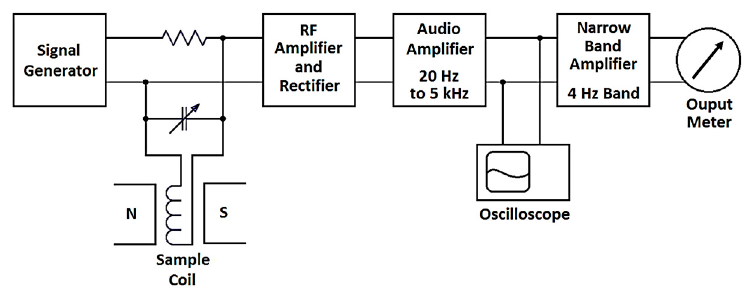
Figure 1. Rollins basic Continuous Wave Nuclear Magnetic Resonanceexperiment.